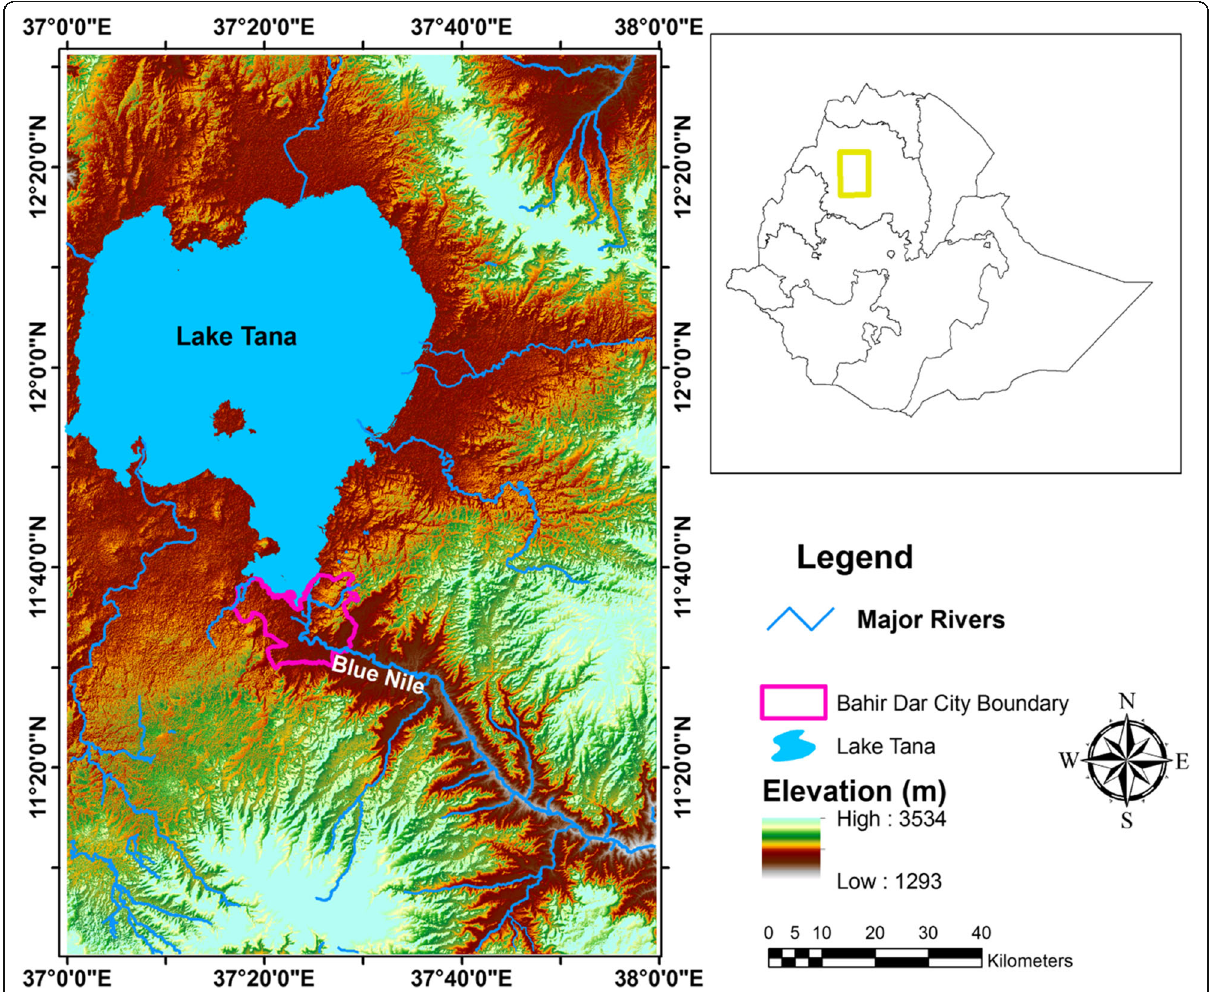
Fig. 1 Location and topography map of the study area. The background is a digital elevation model-based hill-shade obtained from USGS,